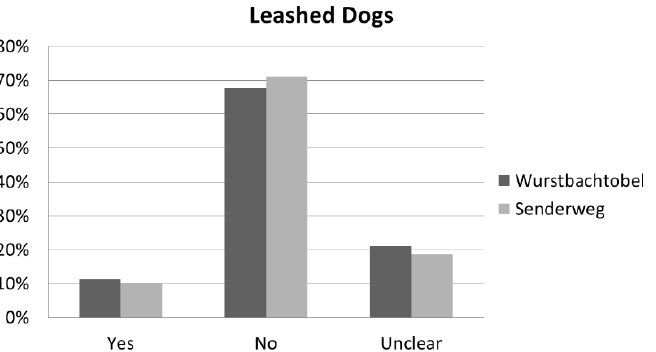
Figure 9. Percentages of dogs leashed at the Wurstbachtobel and Senderweg monitoring sites, Grünten Mountain, Bavaria, Germany, based on periods with in-depth analysis of data (12,008 passersby).